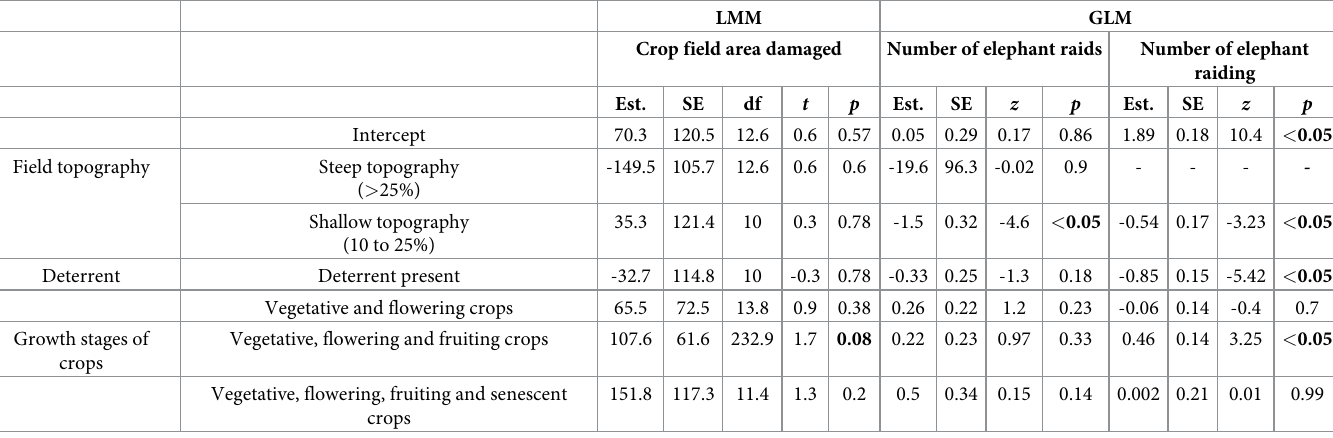
Table 3. Results of generalized linear (GLM) and linear mixed (LMM) models examining factors that best explain the elephant crop-raiding